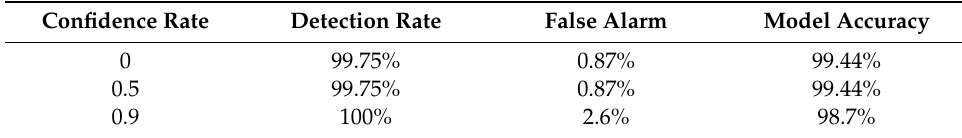
Table 5. Comparison results for different confidence rates.